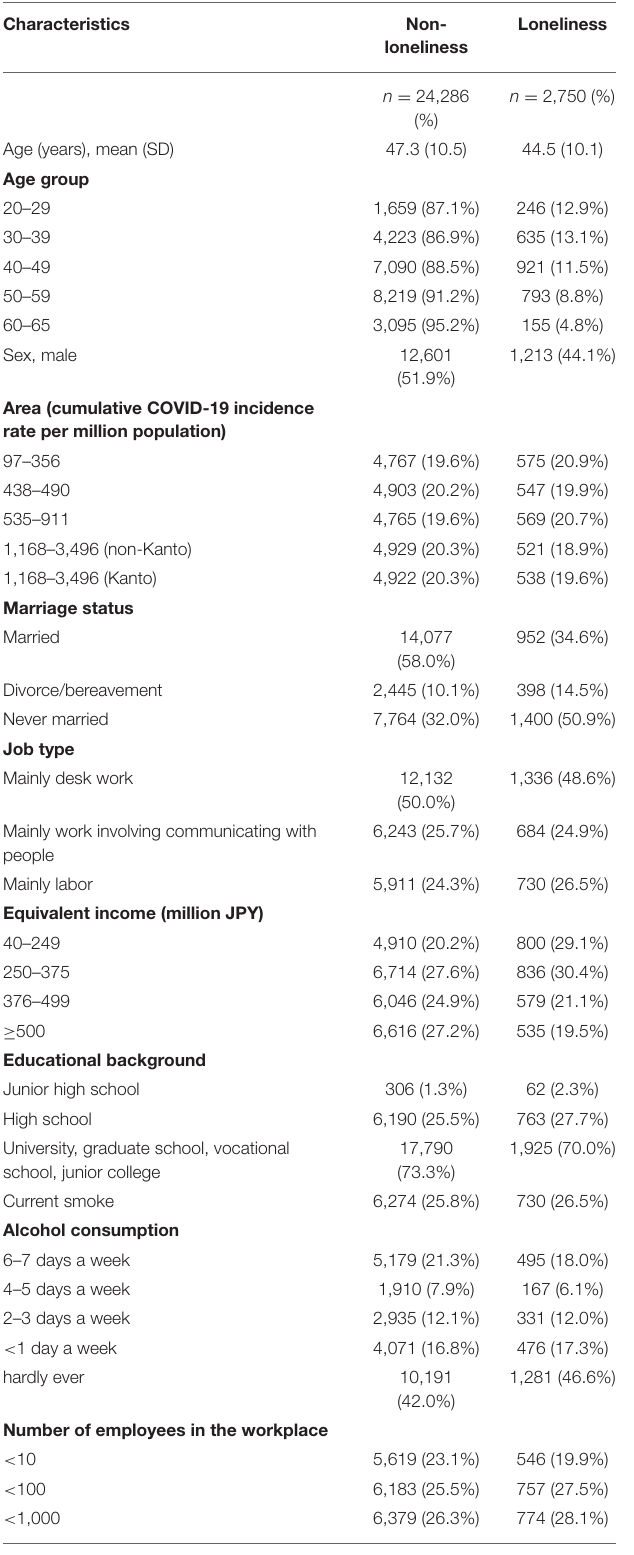
TABLE 1 | The characteristics of participants who have experienced